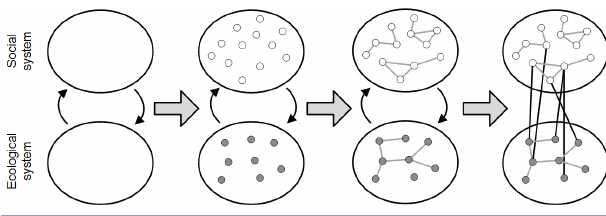
Fig. 1 . Increasing levels of resolution in our examination of social, ecological, and social-ecological interdependencies (left to right). To the left, all details about social and ecological interdependencies are absent, whereas to the right these interdependencies are described as a social-ecological network. The ties represent actor-to-actor (within the social system), resource-to-resource (within the ecological system), and actor- to-resource (across the social and ecological systems)